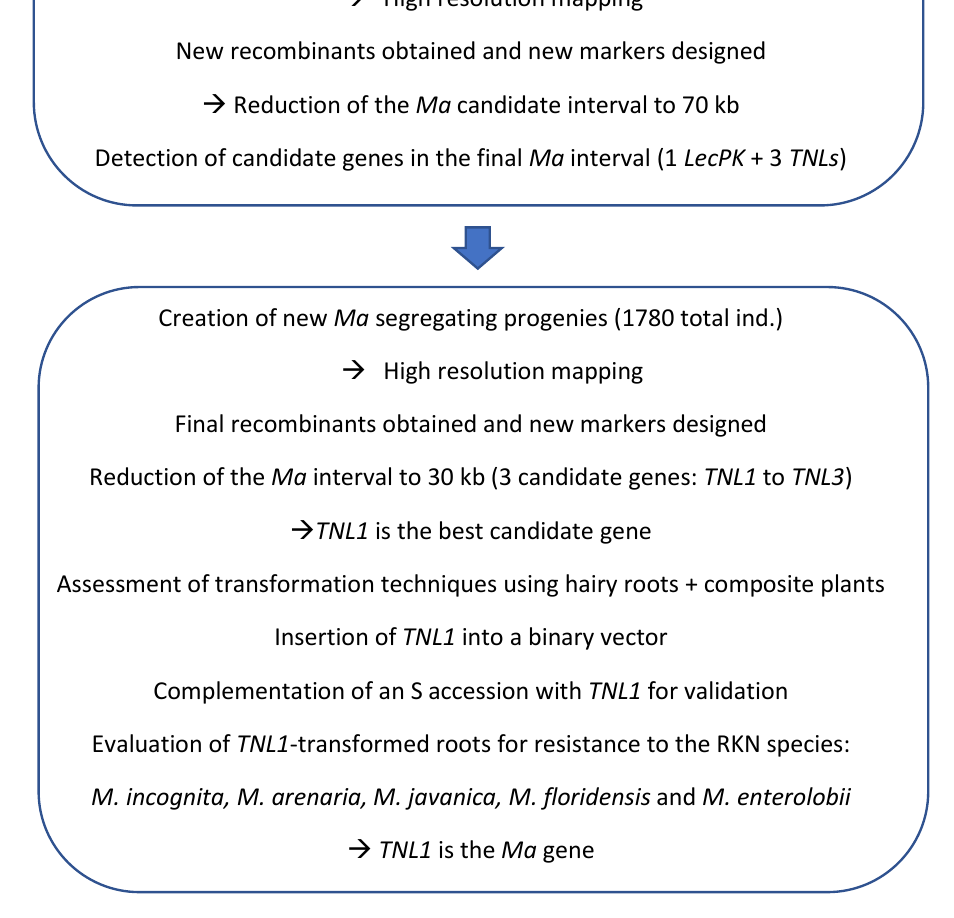
Figure 1. From the plant to the gene: the steps of the RKN resistance study in Myrobalan plum.